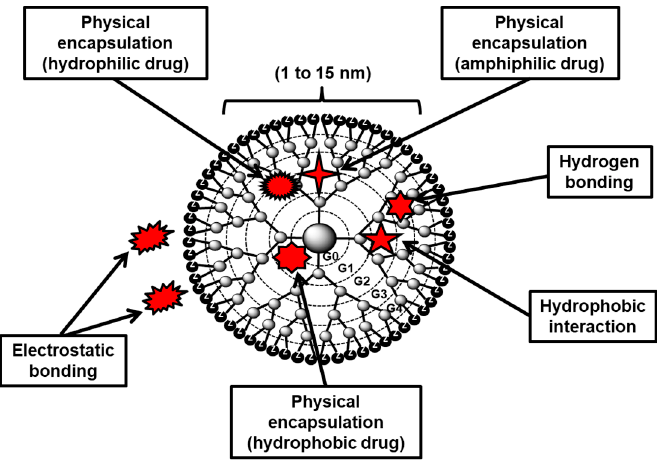
Figure 35. Various generic dendrimer host–guest molecule interactions identified to occur at the exterior or within the interior domains of a dendrimer using recognized NMR protocols.